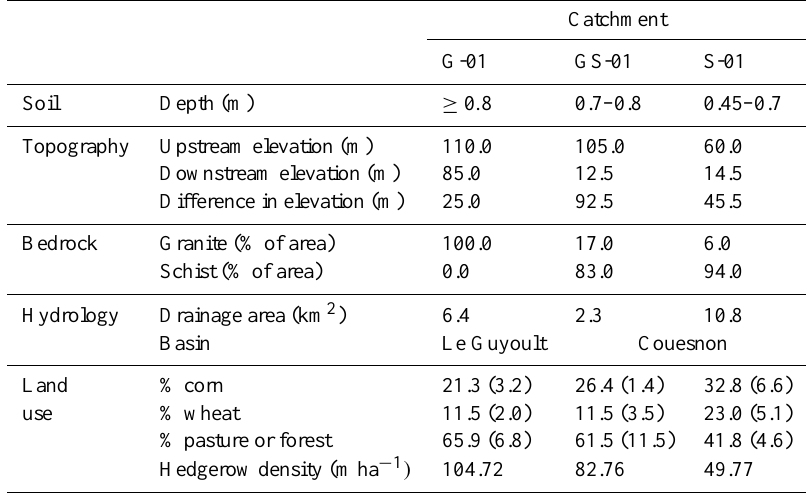
Table 1. Catchment characteristics for the catchments on granite (G-01), schist (S-01), and mixed (GS-01) substrate. Mean (standard devi- ation) of the percentage of corn, cereals, meadows, and woods on arable land use were determined from annual aerial photographs taken during the 5-year study